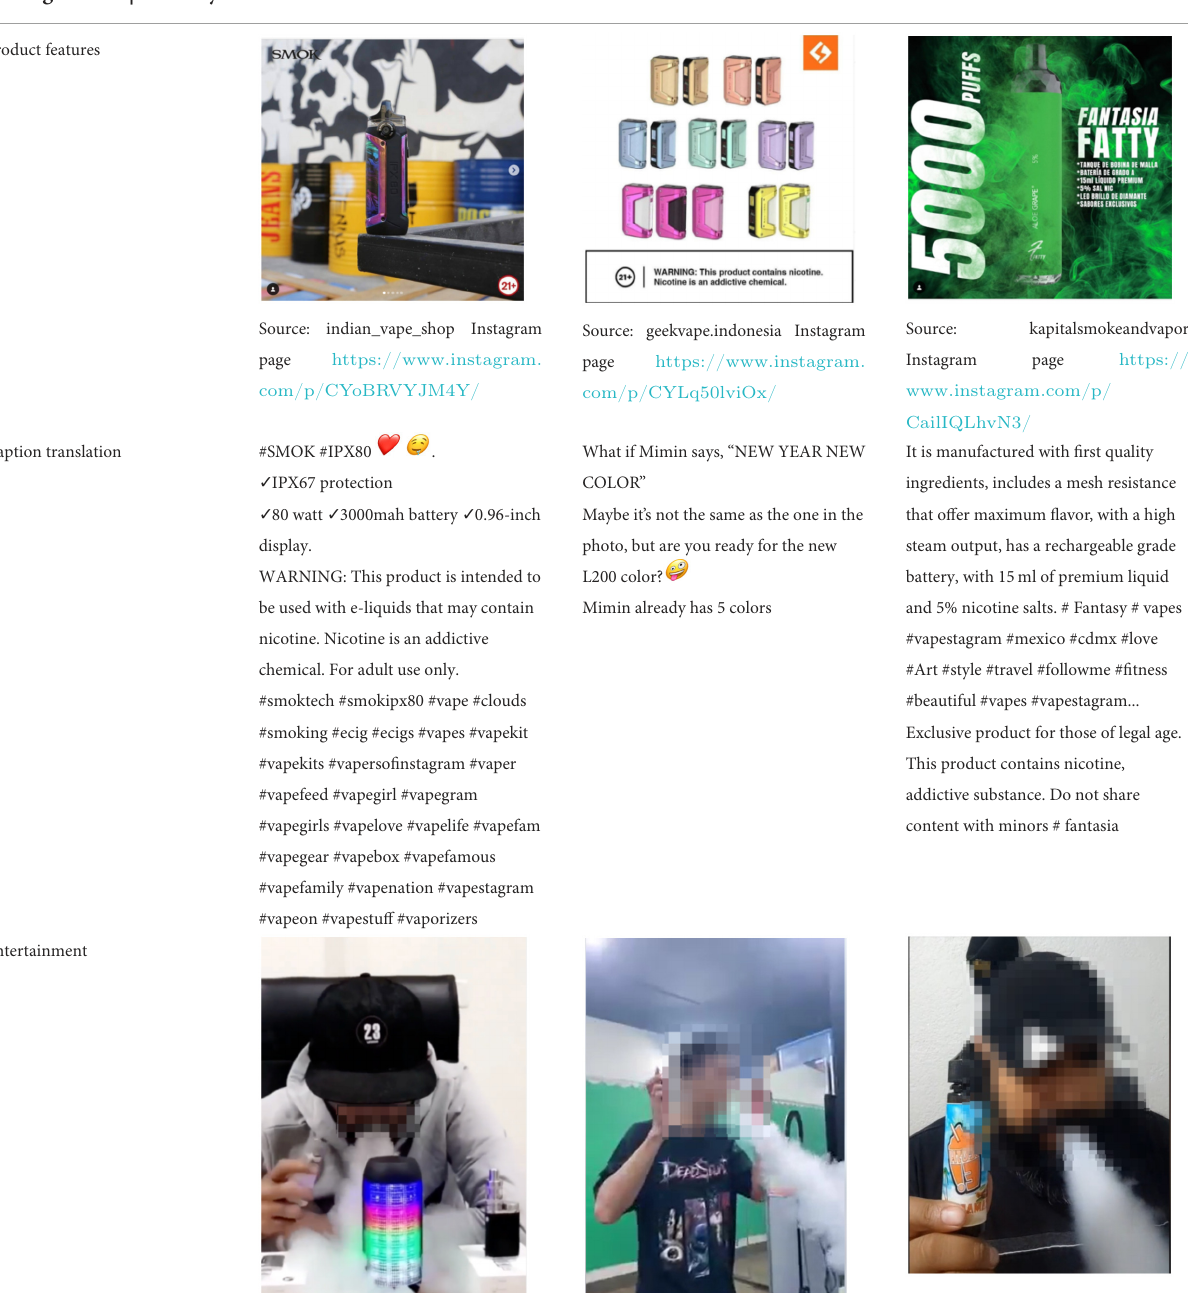
TABLE 3 Types and examples of message framing used in India, Indonesia, and Mexico. Message frame |